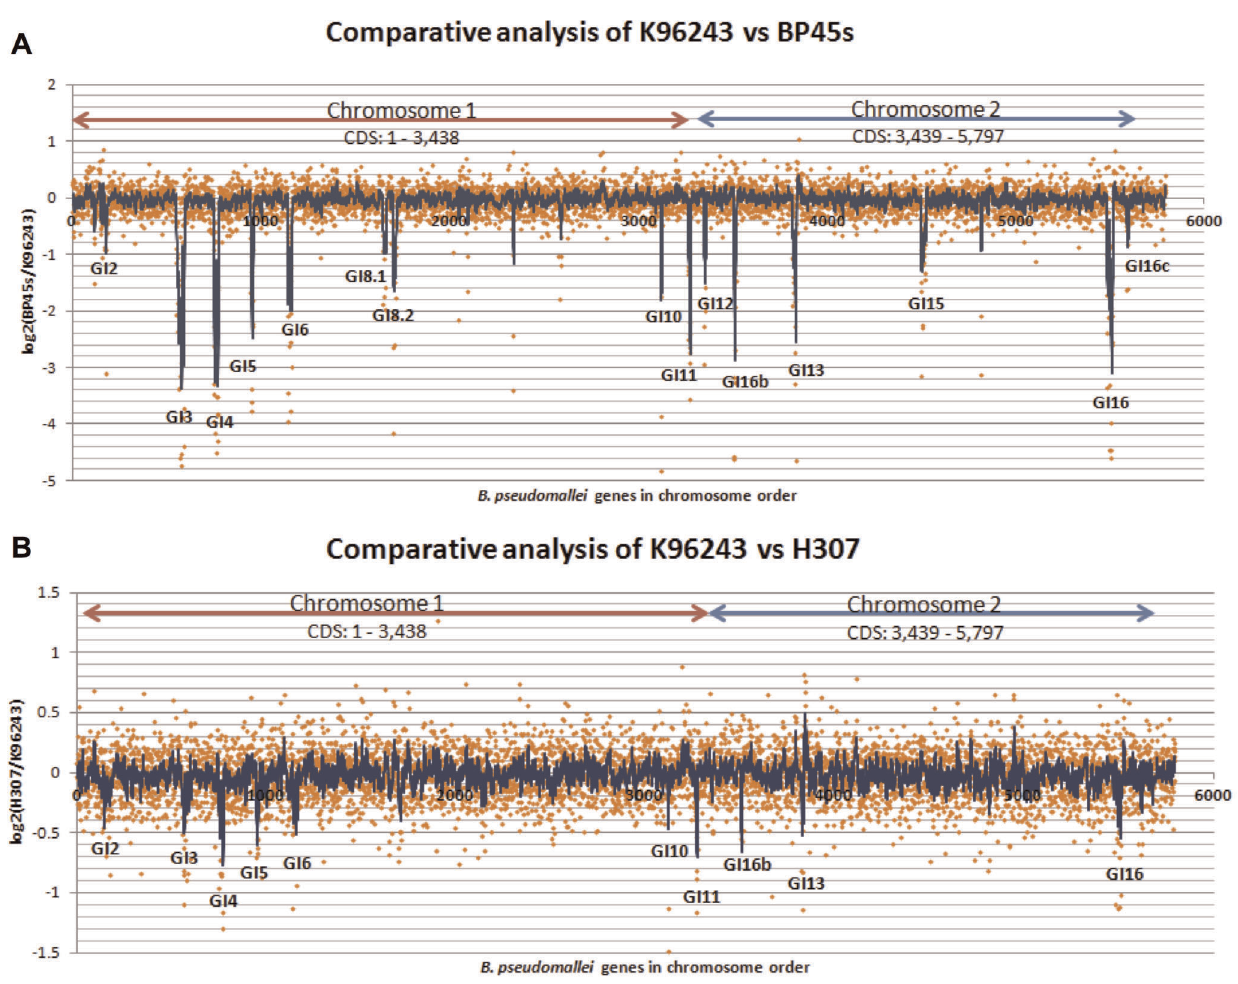
Figure 1. Comparative genome analyses of B.pseudomallei K96243 with B.pseudomallei from environmental and clinical isolates. The comparison between K96243 and environmental isolate (BP45s) was shown in (A) and clinical isolate (H307) in (B). The log 2 hybridization ratio of the tested isolate over the K96243 was plotted on the Y axis and positions of genes on the X axis. Low values of the Log 2 hybridization ratio, seen as peaks, imply absence of genes designated as GIs. The slide averaging window of 6 genes, one gene per step, was applied to the normalized data and smoothed out the fluctuations of the data. Each GI contains at least 6 CDS that have values less than 2 2SD.